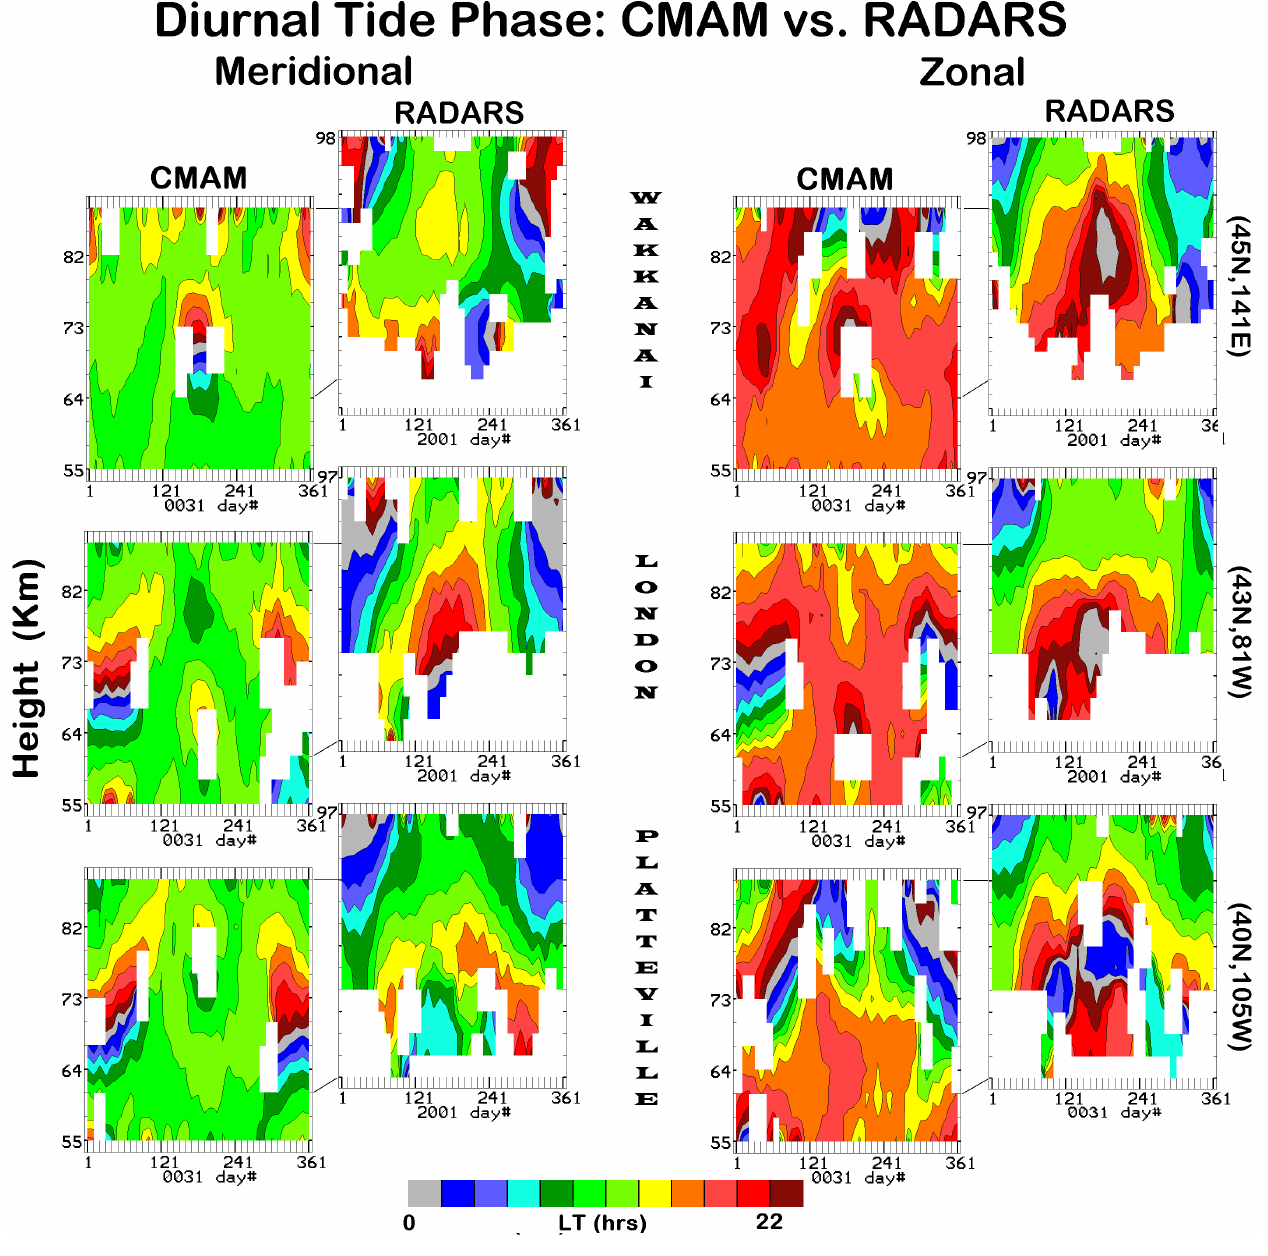
Fig. 7. Annual contour plots (height versus time) of diurnal (24-h) tidal phases for the three CUJO network locations near 45 ◦ N, from both the MF radar observational systems and from CMAM. Zonal (EW) and meridional (NS) components are